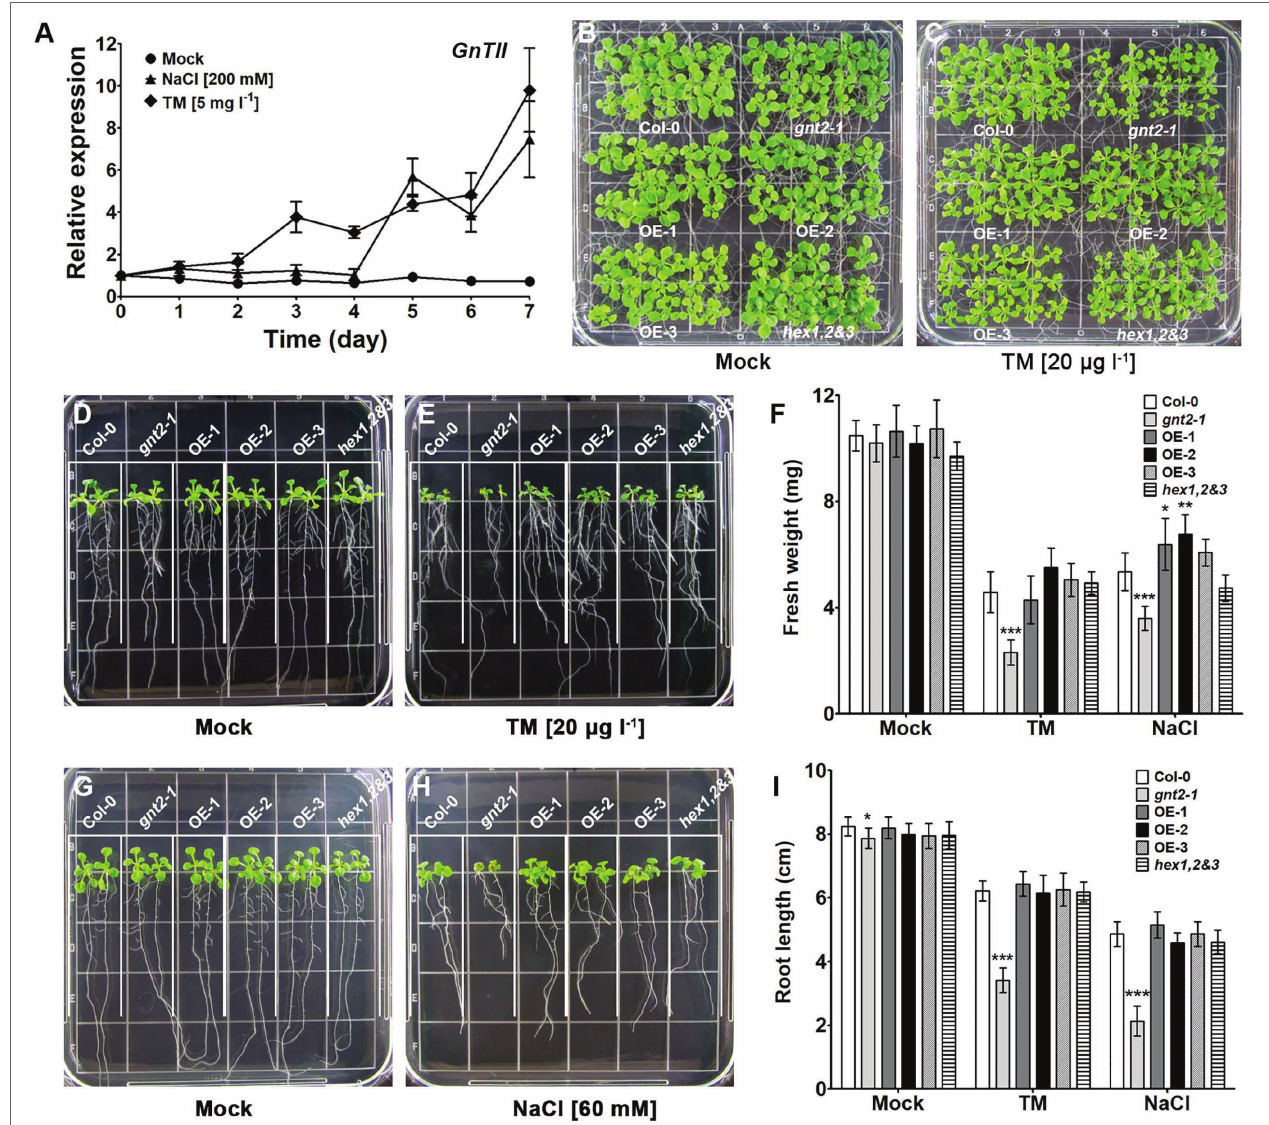
FIGURE 1 | Stress-induced gene expression is associated with developmental defects in the loss-of-function mutant of GnTII ( gnt2-1 ) under stress conditions. (A) Expression of GnTII in 10-day-old Arabidopsis Col-0 seedlings treated with MS medium alone (mock treatment) or supplemented with 200 mm NaCl or 5 mg l − 1 TM for 7 day analyzed by qPCR. The experiment was performed independently three times (three biological replicates) and normalized with respect to β -TUBULIN expression. Data represent means ± SEM of the three independent experiments. (B-I) Col-0, gnt2-1 , OE-1, OE-2, OE-3, and hex1,2&3 plants were grown for 12 day, horizontally (B,C) or vertically (D,E,G,H) , on MS plates (B,D,G) or MS plates containing 20 μ g l − 1 TM (C,E) or 60 mm NaCl (H) , respectively. The grid on the square plate is 18 × 18 mm. Photographs were taken 12 day after plating, and the fresh weight (F) and root length (I) were measured. Asterisks indicate statistically significant differences (* p < 0.05, ** p < 0.01, and *** p < 0.001) as determined by two-way